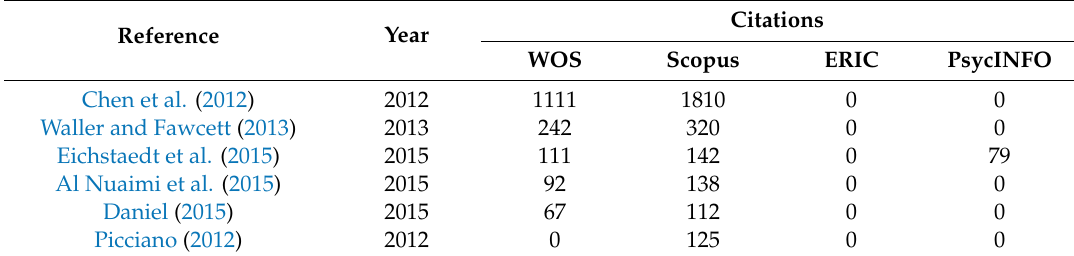
Table 4. The most cited articles in WOS, Scopus, ERIC, and PsycINFO.